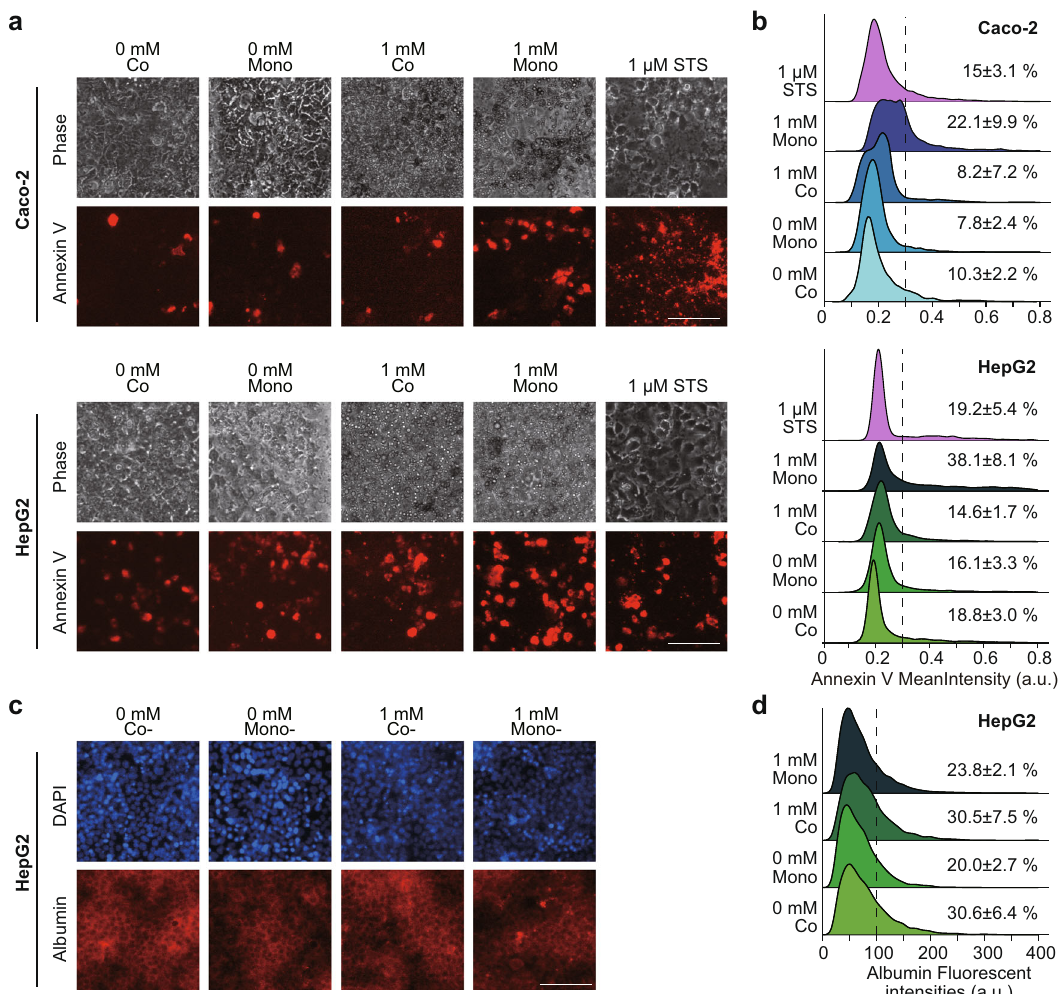
Fig. 4 Accumulated lipids cause apoptosis in both Caco-2 and HepG2 cells. a Phase contrast and fl uorescent micrographs of Caco-2 and HepG2 cells treated with FFAs (0 and 1 mM) stained with the Annexin V apoptotic cell marker. The scale bars represent 100 µ m. b Ridgeline plots to evaluate individual apoptotic cells (Caco-2 and HepG2) after FFAs treatment for 7 days. For comparison, cells were treated with 1 µ M of staurosporine (STS) for 24 h. The p - values were estimated with the Tukey – Kramer test and are presented in Supplementary Tables S7, S8 for the Caco-2 and HepG2 cells, respectively. Cells with over 0.3 of Annexin V fl uorescent intensity were considered as apoptotic cells. c Phase contrast and fl uorescent micrographs of HepG2 cells treated with FFAs (0 and 1 mM) stained with the human albumin. The scale bars represent 100 µ m. d Ridgeline plots to evaluate individual HepG2 cells with human albumin expression after FFAs treatment for 7 days. The p -values were estimated with the Tukey – Kramer test and are presented in Supplementary Table S9 for the HepG2 cells. Cells with over 100 of ALB fl uorescent intensity were considered as ALB-expressing cells. The data represent the mean ± standard deviation ( n =